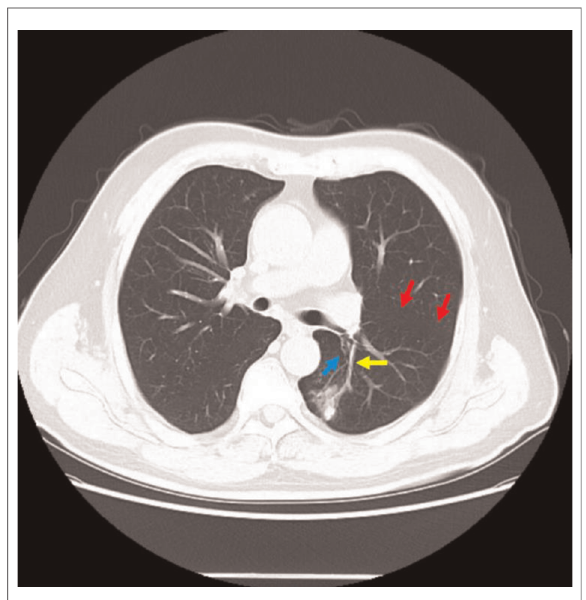
FIGURE 1 CT imaging of the patient before the surgery. The red arrow refers to the oblique fi ssure, the yellow arrow refers to the S6 artery, and the blue arrow refers to the S6 bronchus, regarded by radiologists and